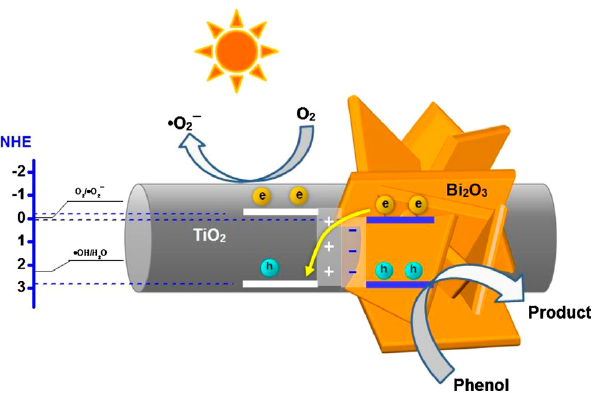
Figure 11. Schematic mechanism of phenol removal by photocatalysis using Bi 2 O 3 /TiO 2 NFs [92]. Reproduced with permission from Elsevier, 2022.